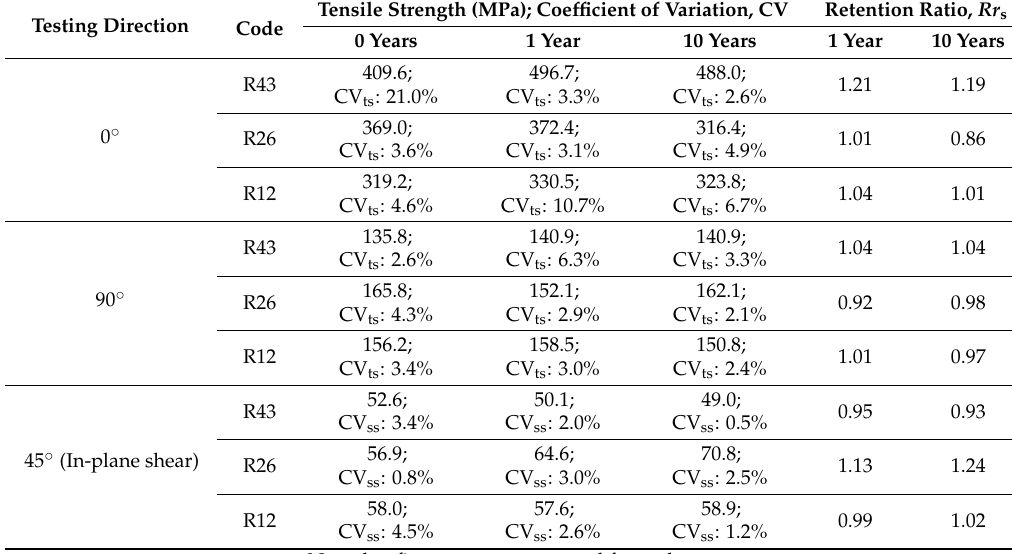
Table 7. Tensile and in-plane shear strengths of painted specimens with retention ratios.